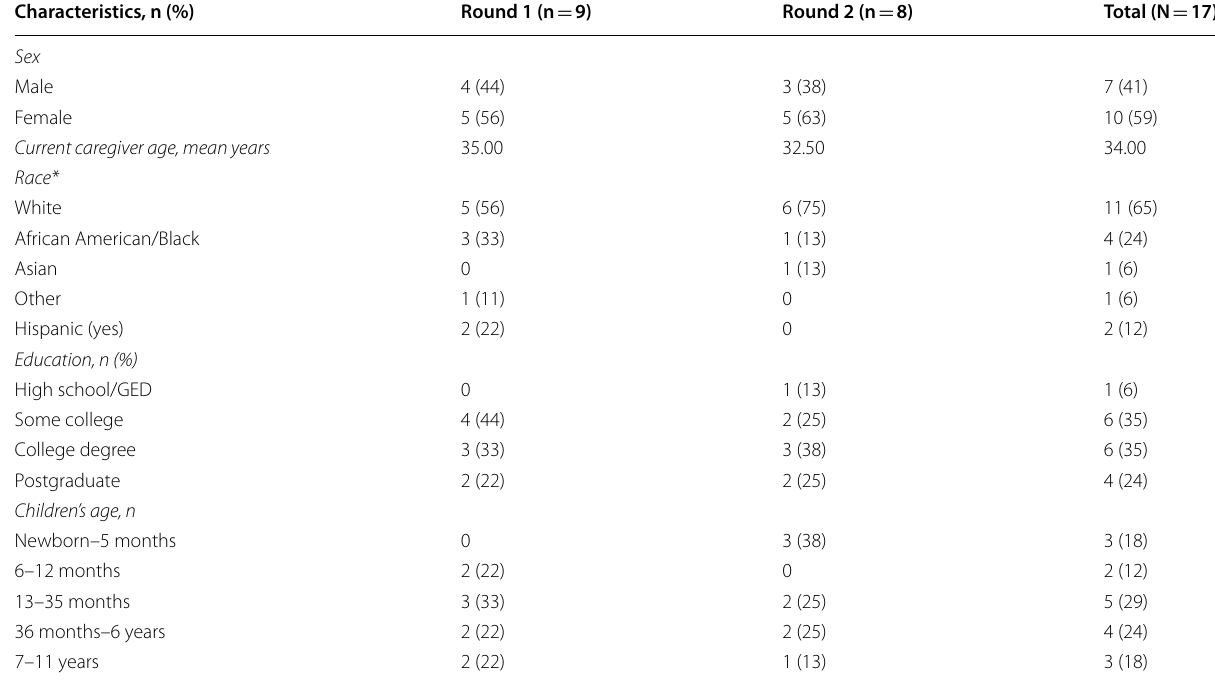
*Total for race exceeds 100% due to rounding